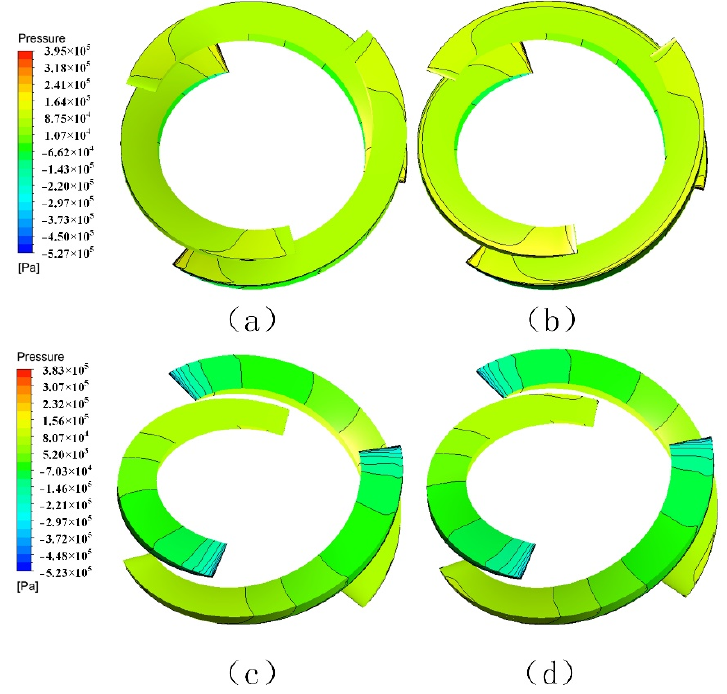
Figure 11. Distribution of surface static pressure on impeller at GVF = 20% working condition. ( a ) Pressure side of original model; ( b ) pressure side of optimized model; (c) suction side of original model; ( d ) suction side of optimized model.